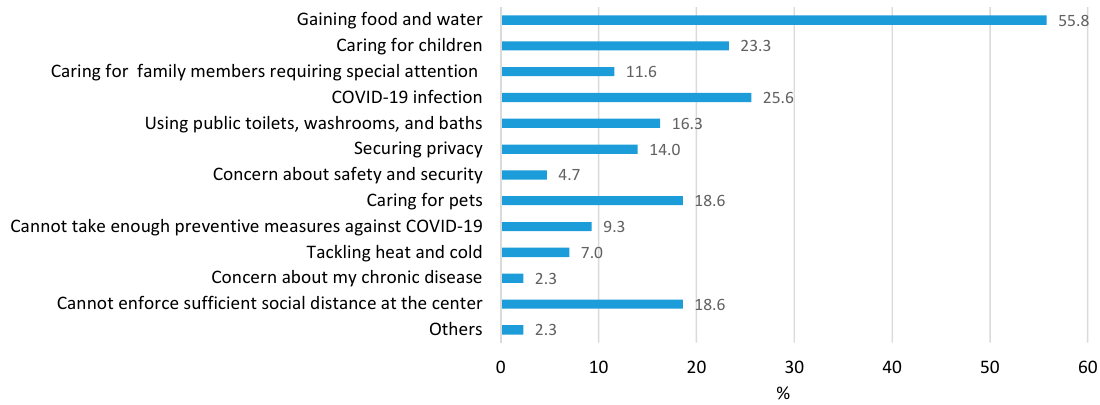
Figure 2. Concerns of the respondents at the time of evacuation.